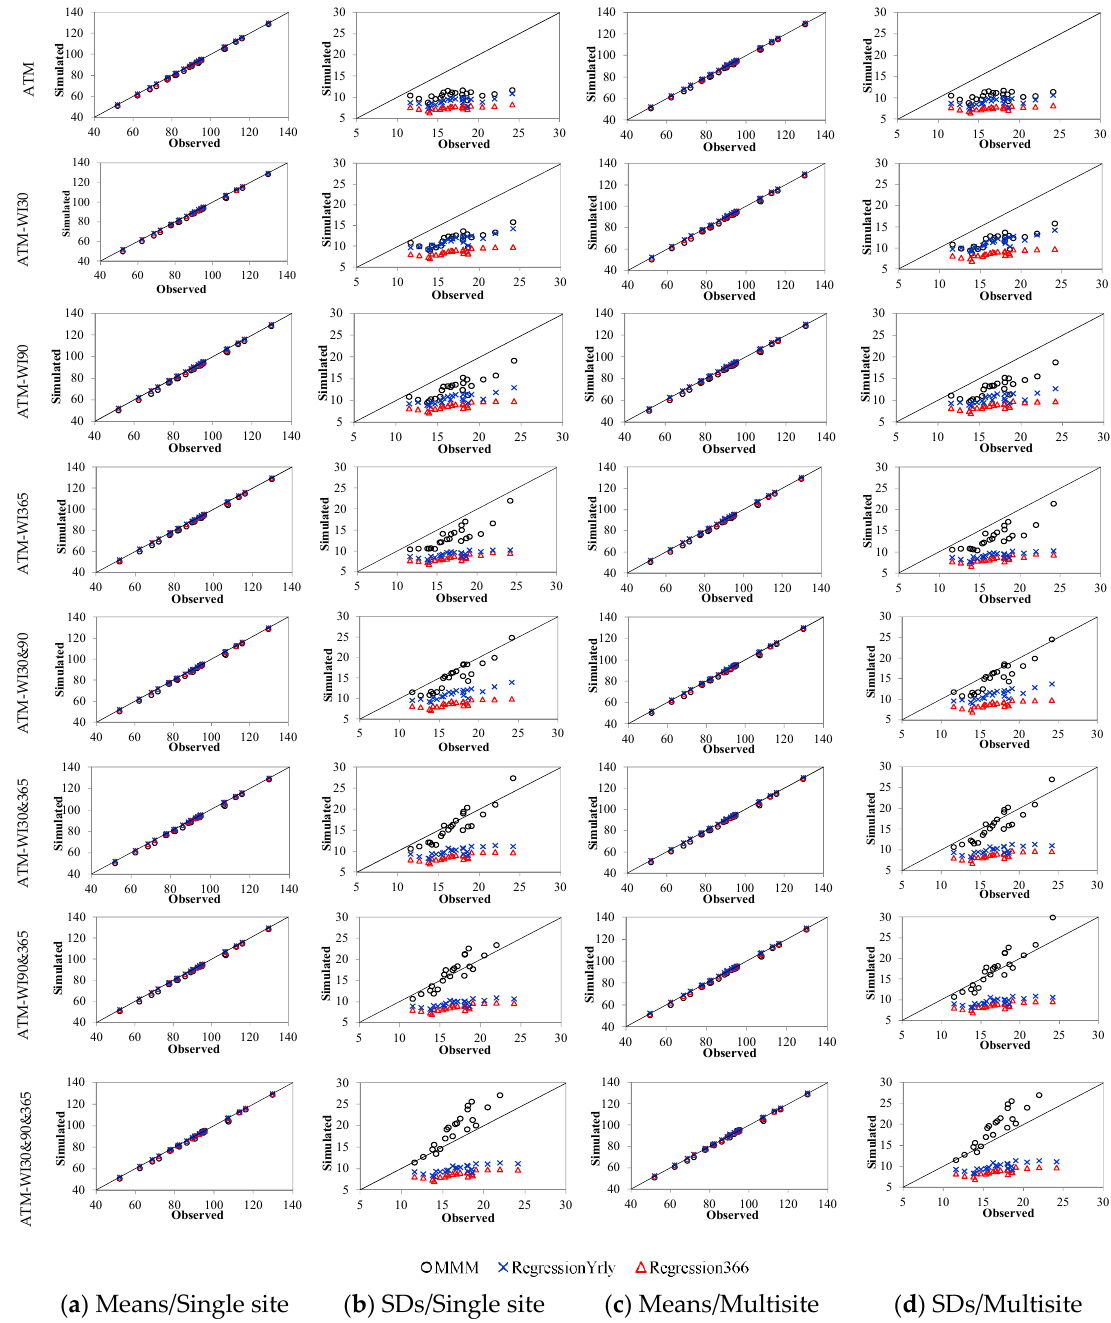
Figure 2. Scatter plots of means and standard deviations of observed and simulated annual wet days at each rainfall station for calibration: ( a ) means using single site simulations; ( b ) standard deviations using single site simulations; ( c ) means using multisite simulations; and ( d ) standard deviations using multisite simulations. Each dot on the plot represents a station. Black hollow circles are for MMM, blue crosses are for RegressionYrly and red triangles are for Regression366 models.